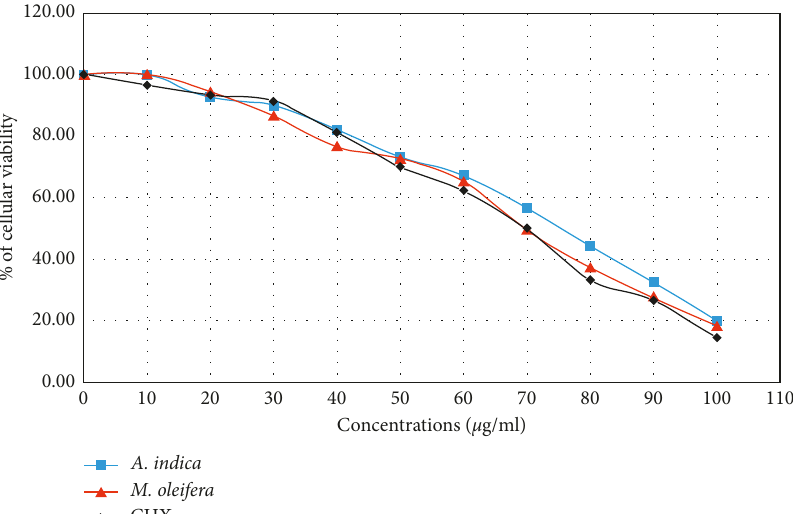
Figure 1: Cellular viability evaluation of Jurkat cells against the methanolic extracts of Moringa oleifera and Azadirachta indica against Enterococcus faecalis